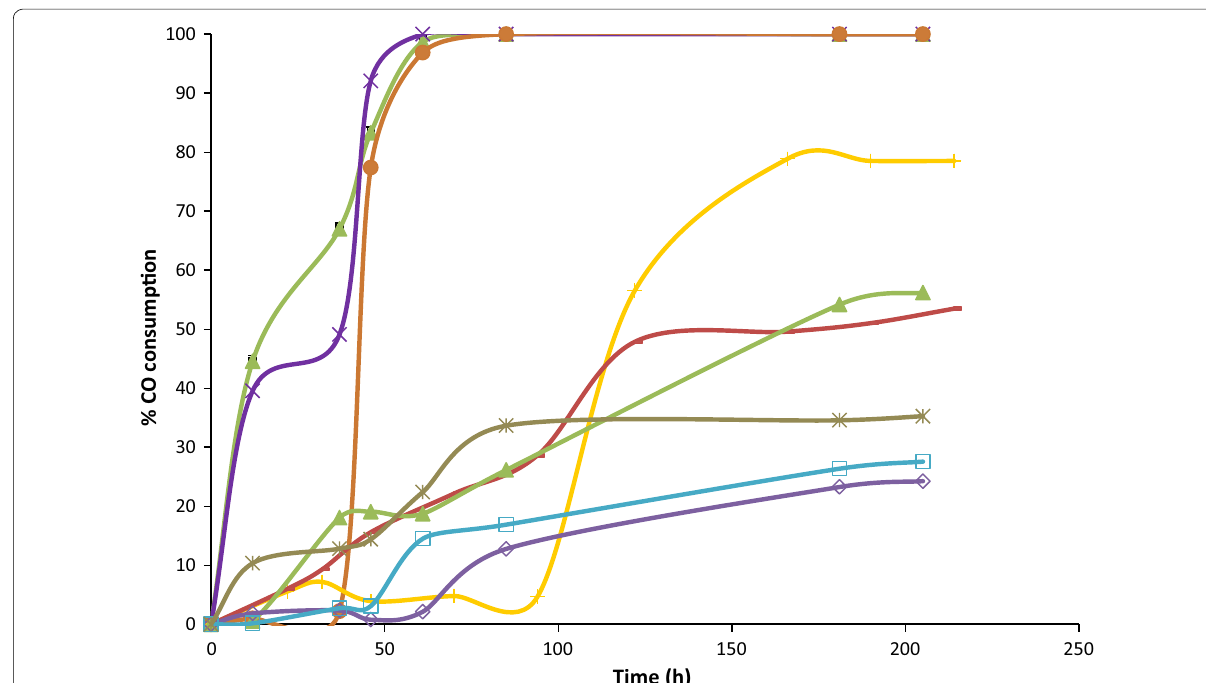
Fig. 5 Percentage of carbon monoxide consumption over time. (0.2 g/L of sodium chloride represented as filled triangle, 3 g/L of sodium chloride represented as X, 9 g/L of sodium chloride represented as filled circle, 10 g/L of sodium chloride represented as represented as , 12 g/L of sodium chloride represented as filled diamond, 15 g/L of sodium chloride represented as open triangle, 18 g/L of − sodium chloride represented as open square and 21 g/L of sodium chloride represented as